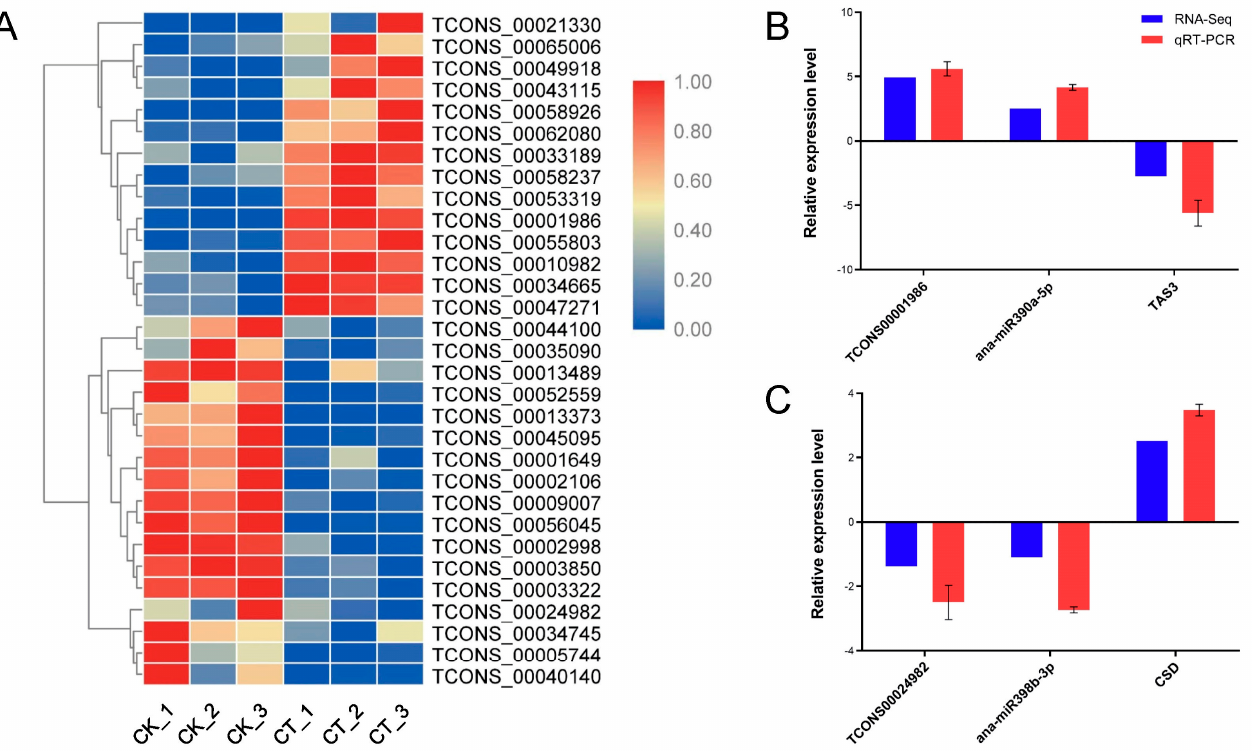
Figure 8. Differential expression of the cold stress-responsive lncRNAs representing miRNA precursors. ( A ) Heatmap of the lncRNAs representing miRNA precursors related to cold stress in A. nanus . ( B ) qRT-PCR verifies the expression patterns of TCONS00001986 , miR390 , and TAS3 . ( C ) qRT-PCR verifies the expression patterns of TCONS00024982 , miR398 , and CSD .